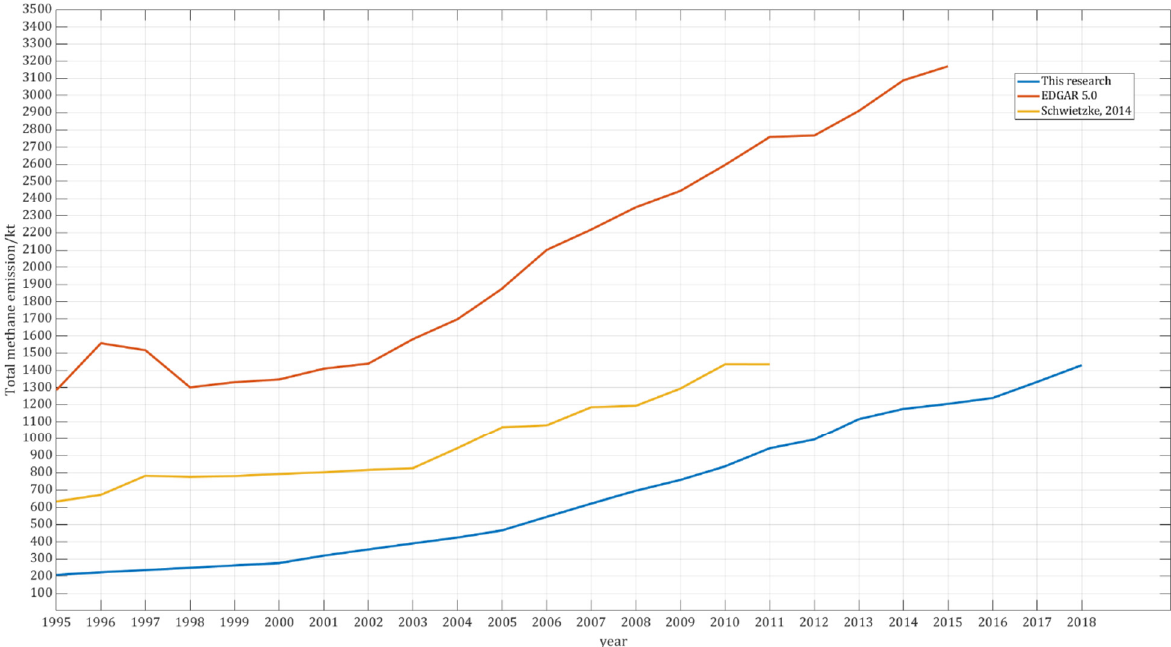
Figure 2. Total methane emission and uncertainty from China’s oil and natural gas sector, 1995–2018.